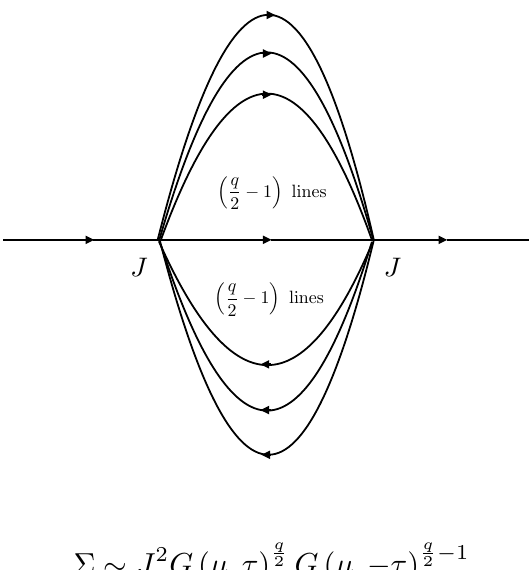
(cid:0) q (cid:1) (cid:0) 1 2